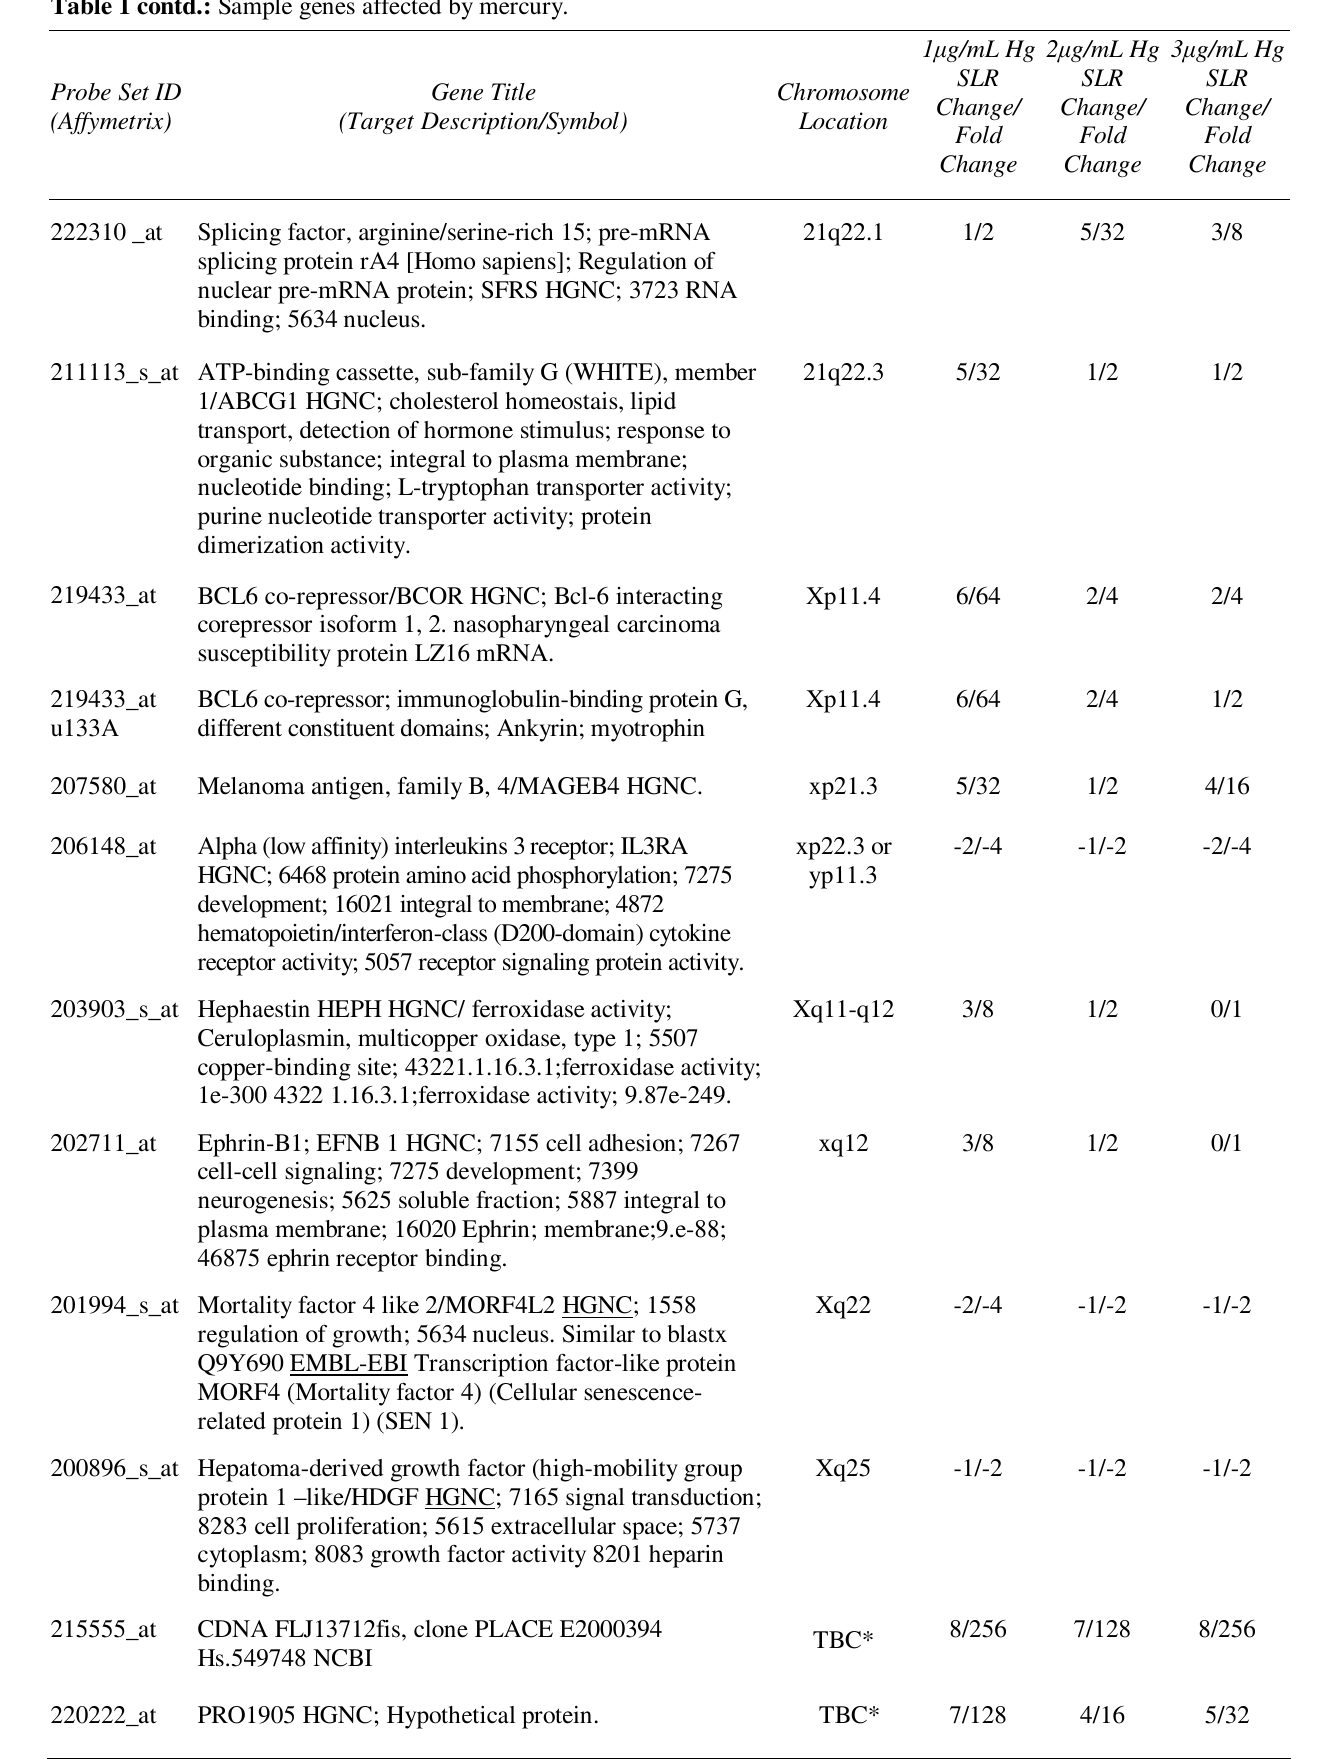
Table 1 contd.: Sample genes affected by